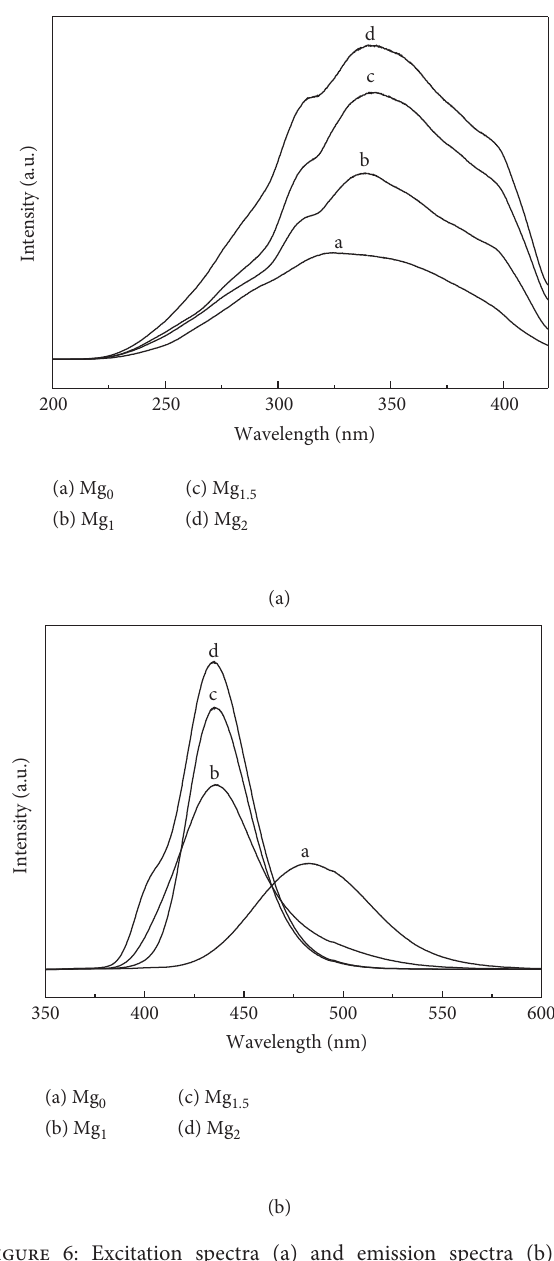
F 6: Excitation spectra (a) and emission spectra (b)